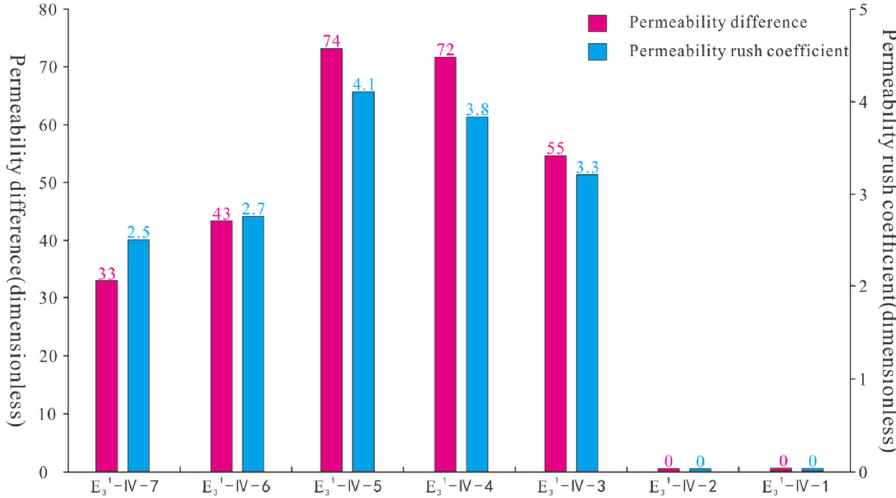
Figure 6. Distribution histograms of permeability difference and permeability rush coefficient. Table 2. Identification plate of effective reservoir and interlayer in the Qie12